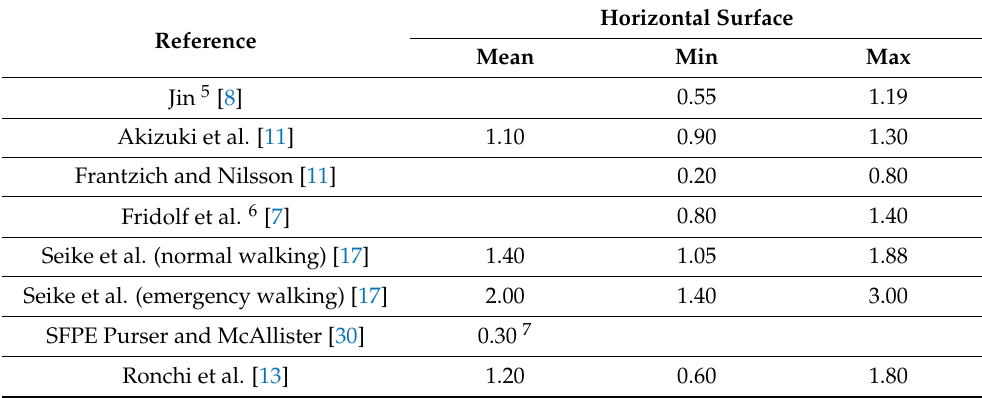
Table 2. Walking speed (m/s) in smoke-filled